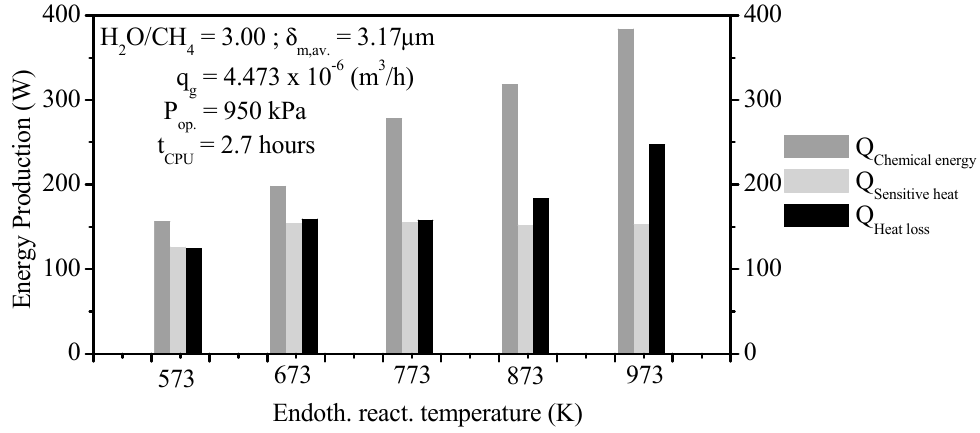
Figure 11. Energy storage performance of the thermochemical system as a function of the ERT.